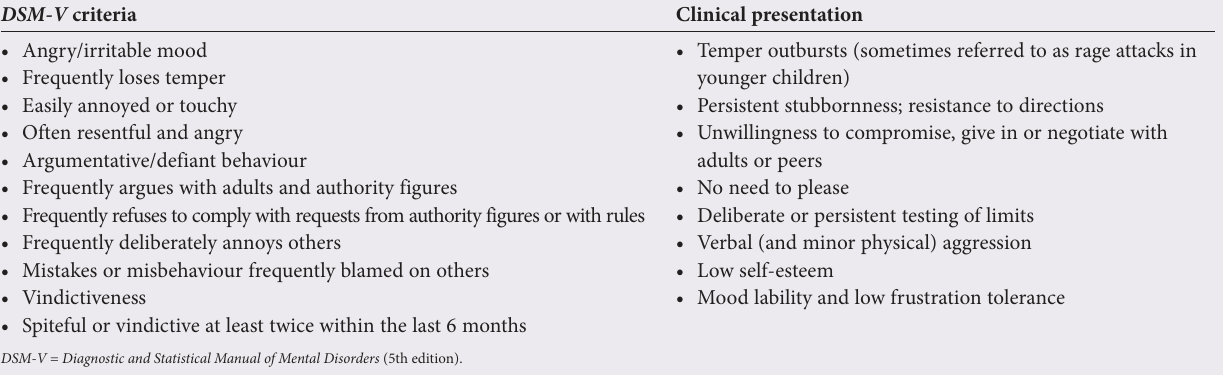
Table 11. Overview of oppositional defiant